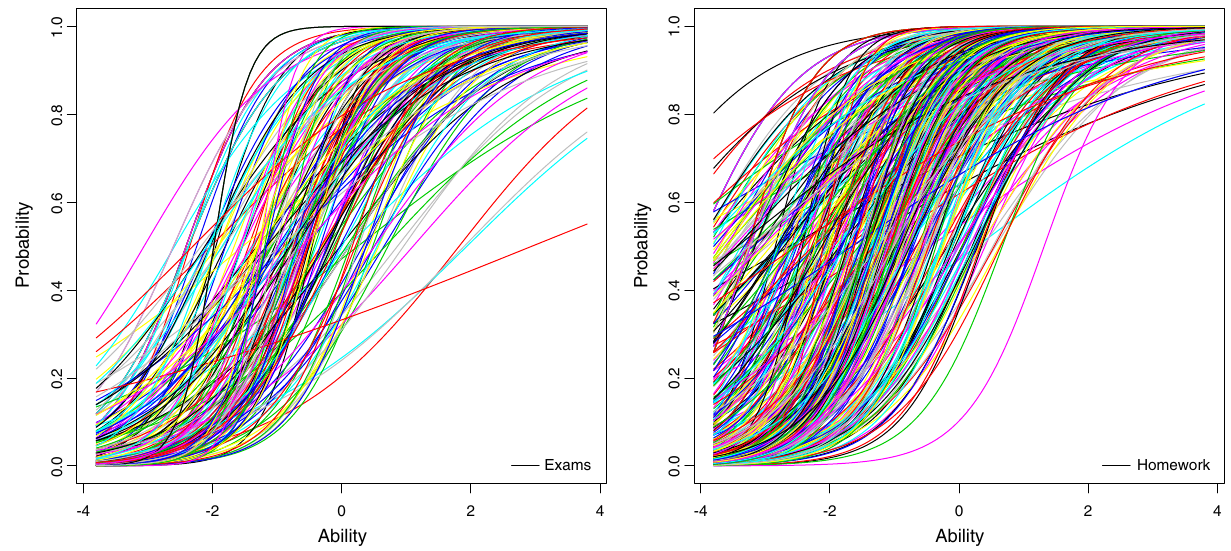
FIG. 3. Item characteristic curves for exam items (left) and homework items (right). Homework items were considered correct if the learner solved them eventually, regardless of number of attempts.